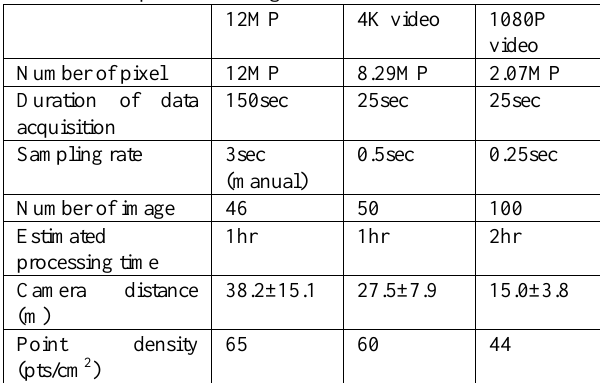
Table 4. Comparison of images and videos for a